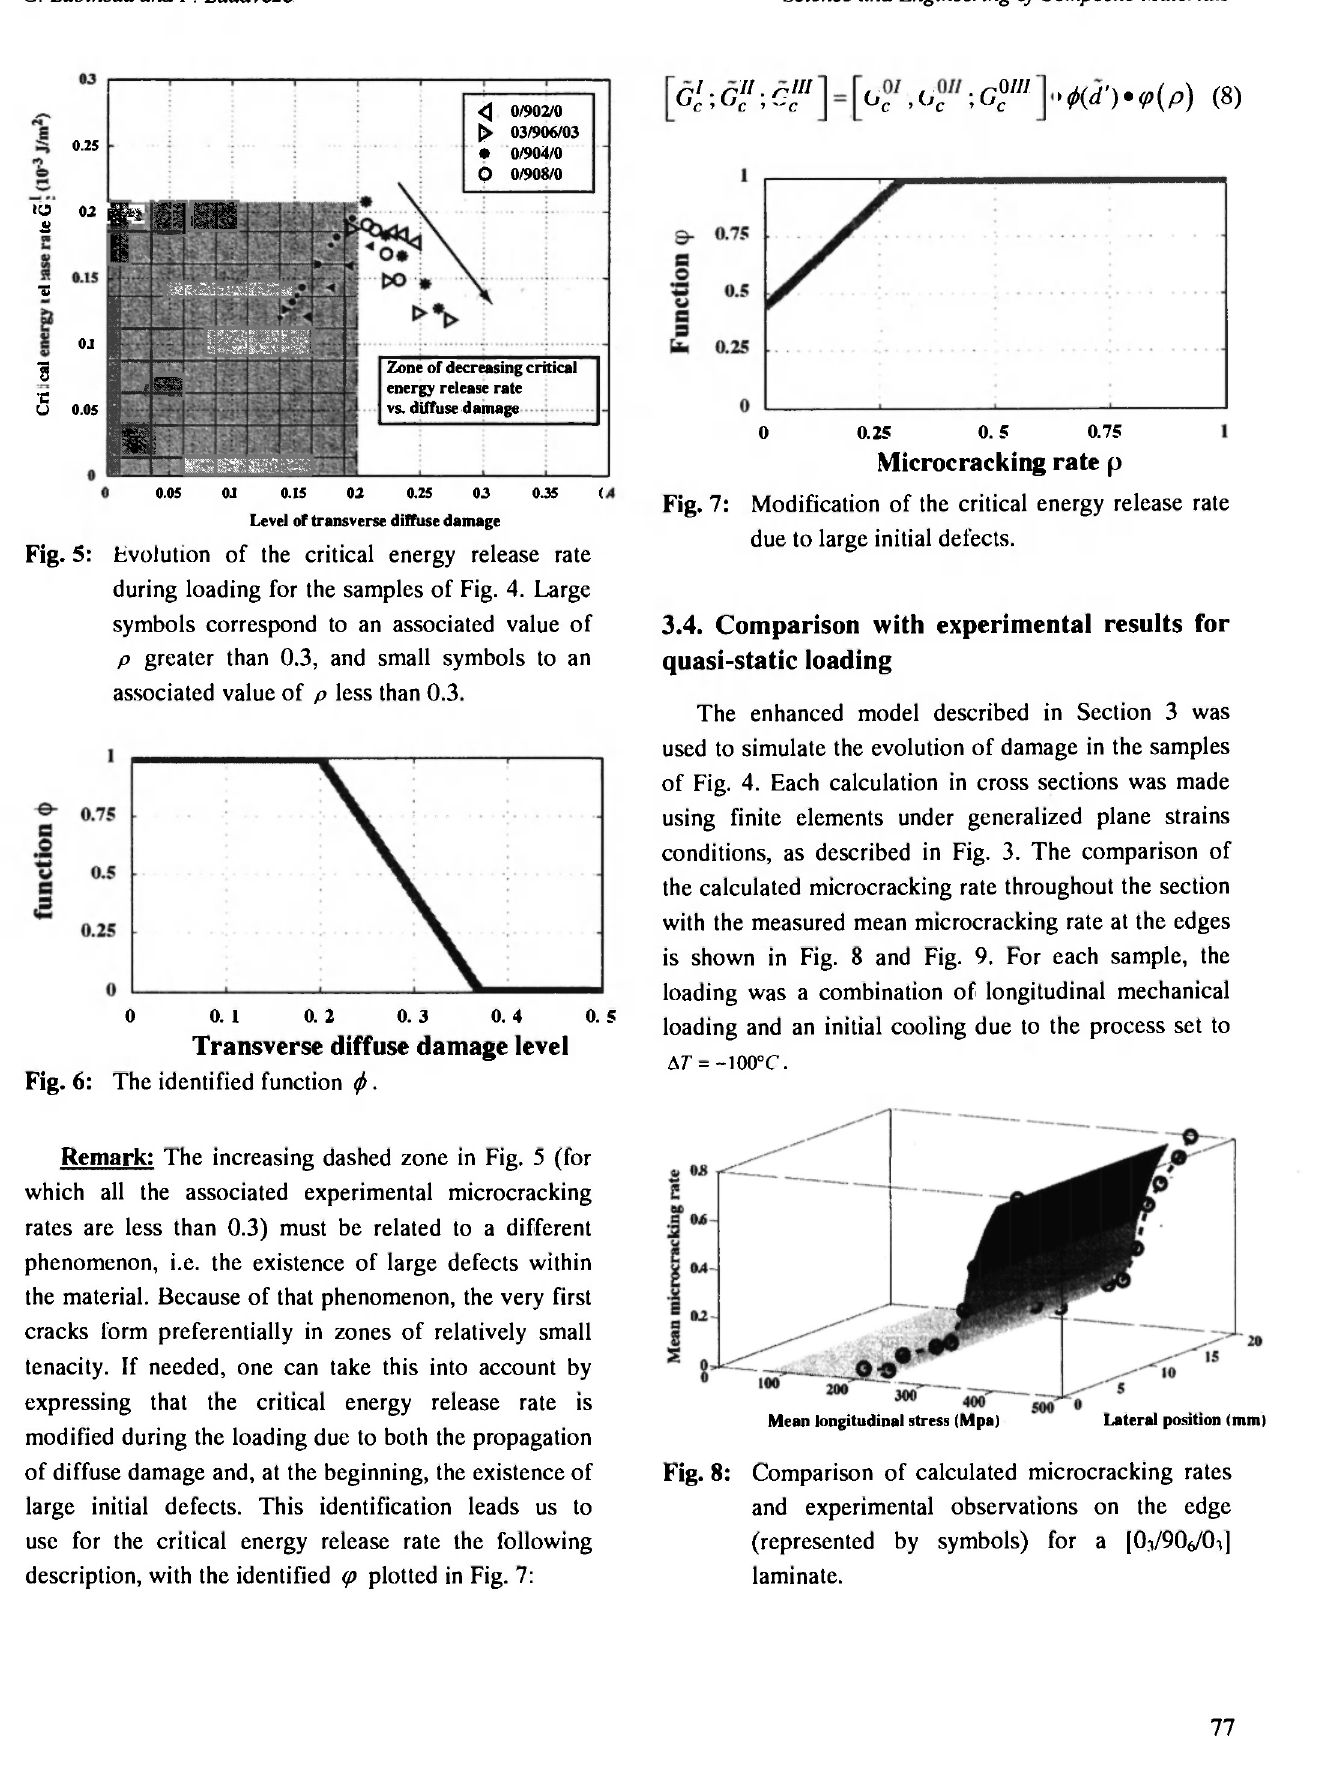
Fig. 7: Modification of the critical energy release rate due to large initial defects.